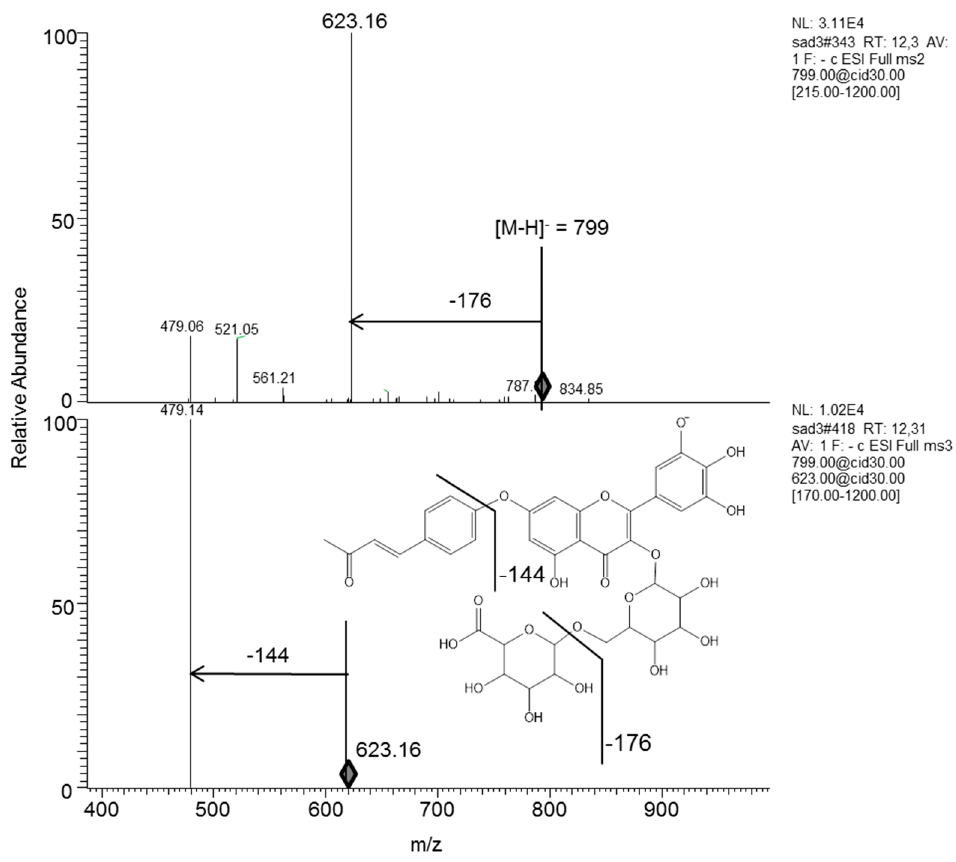
Figure 2. ESI-MS n mass spectra of [M-H] − generated from compound 11 ( m/z 799): myricetin-3- O -glucoside glucuronic acid-7-O- p